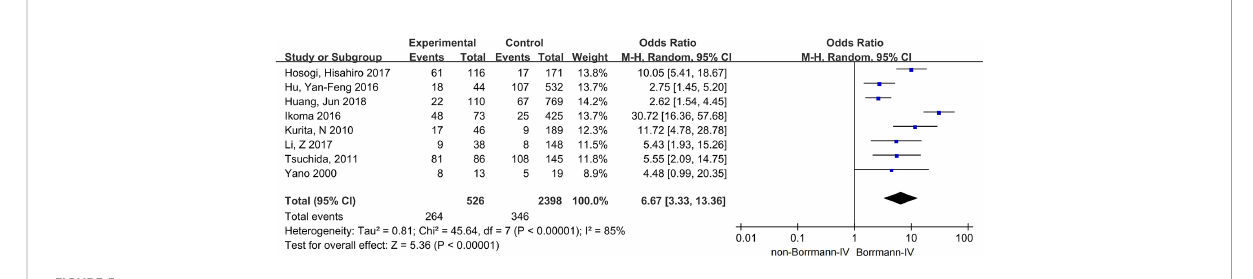
FIGURE 5 The correlation between Borrmann type IV and PC.